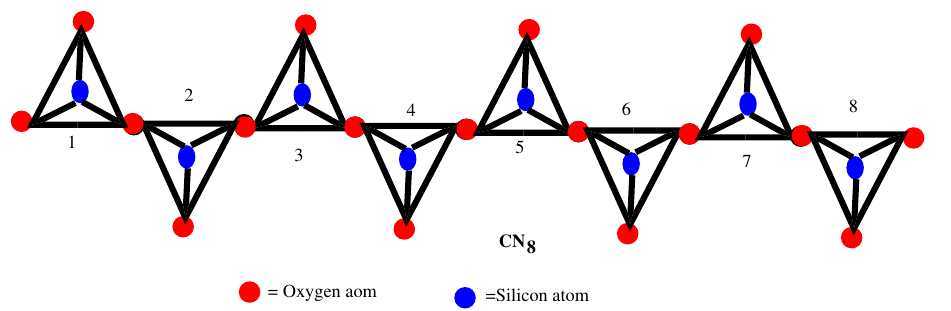
Figure 2. Silicate chain network of dimension 8.